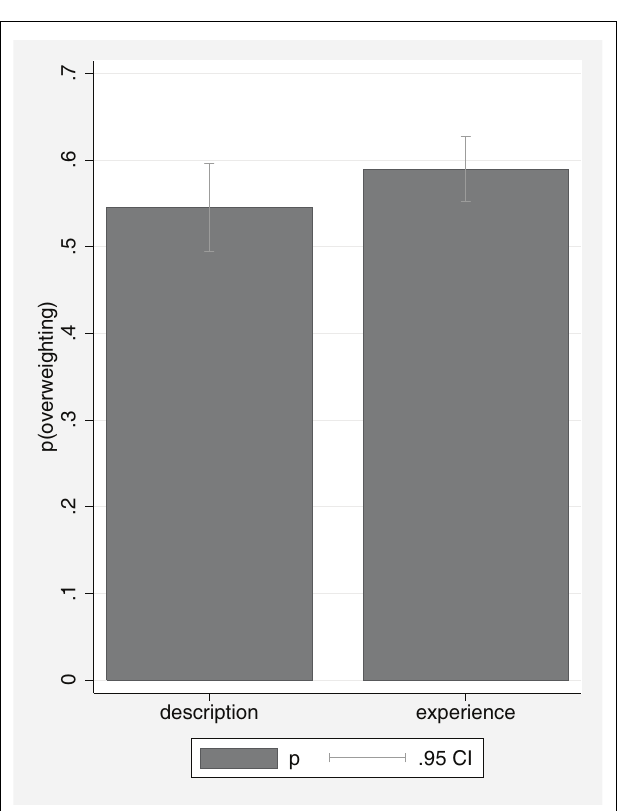
FIGURE 2 | Proportion of fixations to the rare events compared to their objective probability. Note. Proportions of fixations are calculated using fixations to outcomes only. Proportions are calculated within gambles as the number of fixations to the rare event divided by the total fixations to the rare event and the alternative outcome of the respective gamble. Note that in the experience condition, the sampling rate of the rare event was 0.084, which is roughly reflects in the fixation rate.